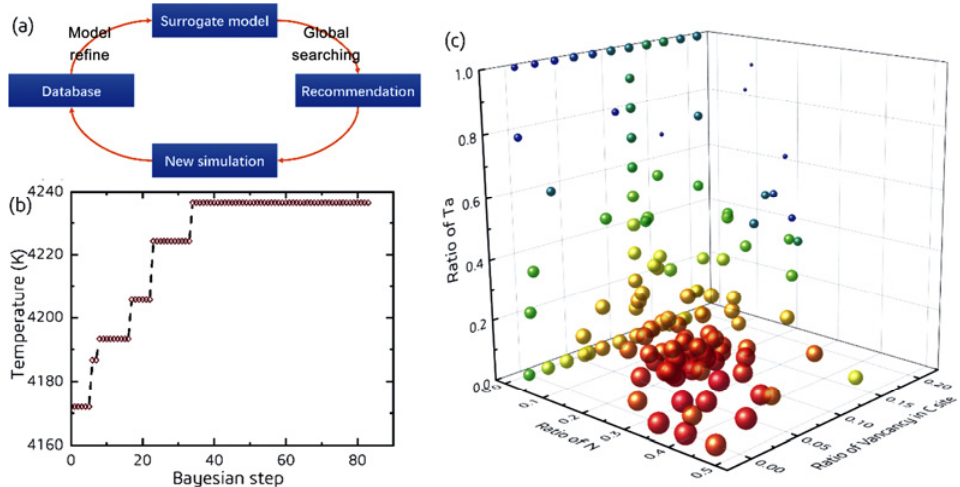
Fig. 6 (a) Schematic illustration of BGO. (b) Variation of searched highest melting point as a function of iteration step. (c) Variation of melting point with respect to composition of Hf 1 − y Ta y C 1 − x − z N z . In (c), the bigger the sphere is, the higher the melting point is. The smallest melting point and the highest melting point in (c) are 3908 and 4236 K,